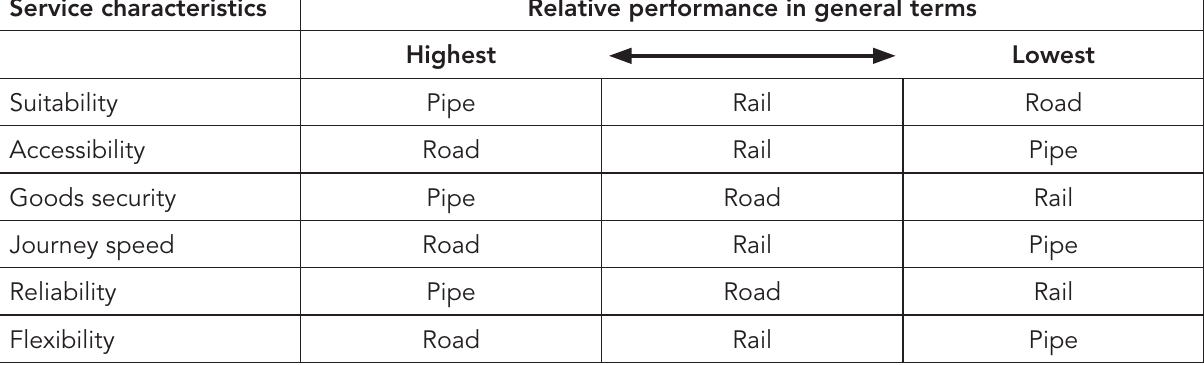
Table I: Service comparison of transport modes used for the carriage of petroleum commodities over long distances on land (Source: Pienaar,